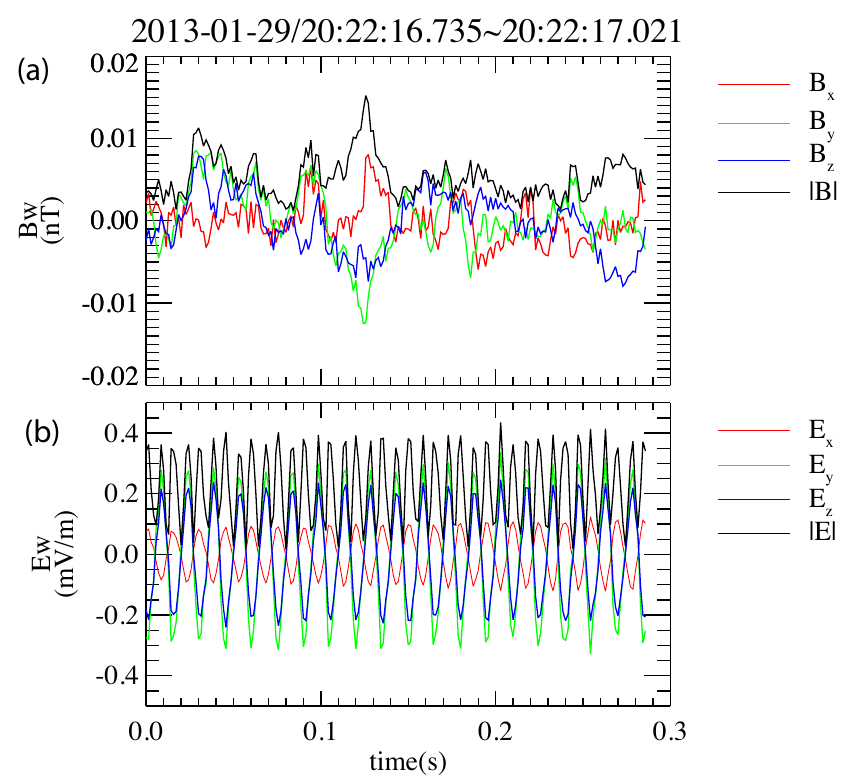
Figure 2. The waveform of the identified time-domain structures. ( a ) The magnetic field signature. ( b ) Electric field signature. The electric and magnetic fields are in field-aligned coordinate. In this coordinate, both x and y are transverse components, and the z axis is the direction along the background magnetic field. This moment is marked with a white vertical line in Figure